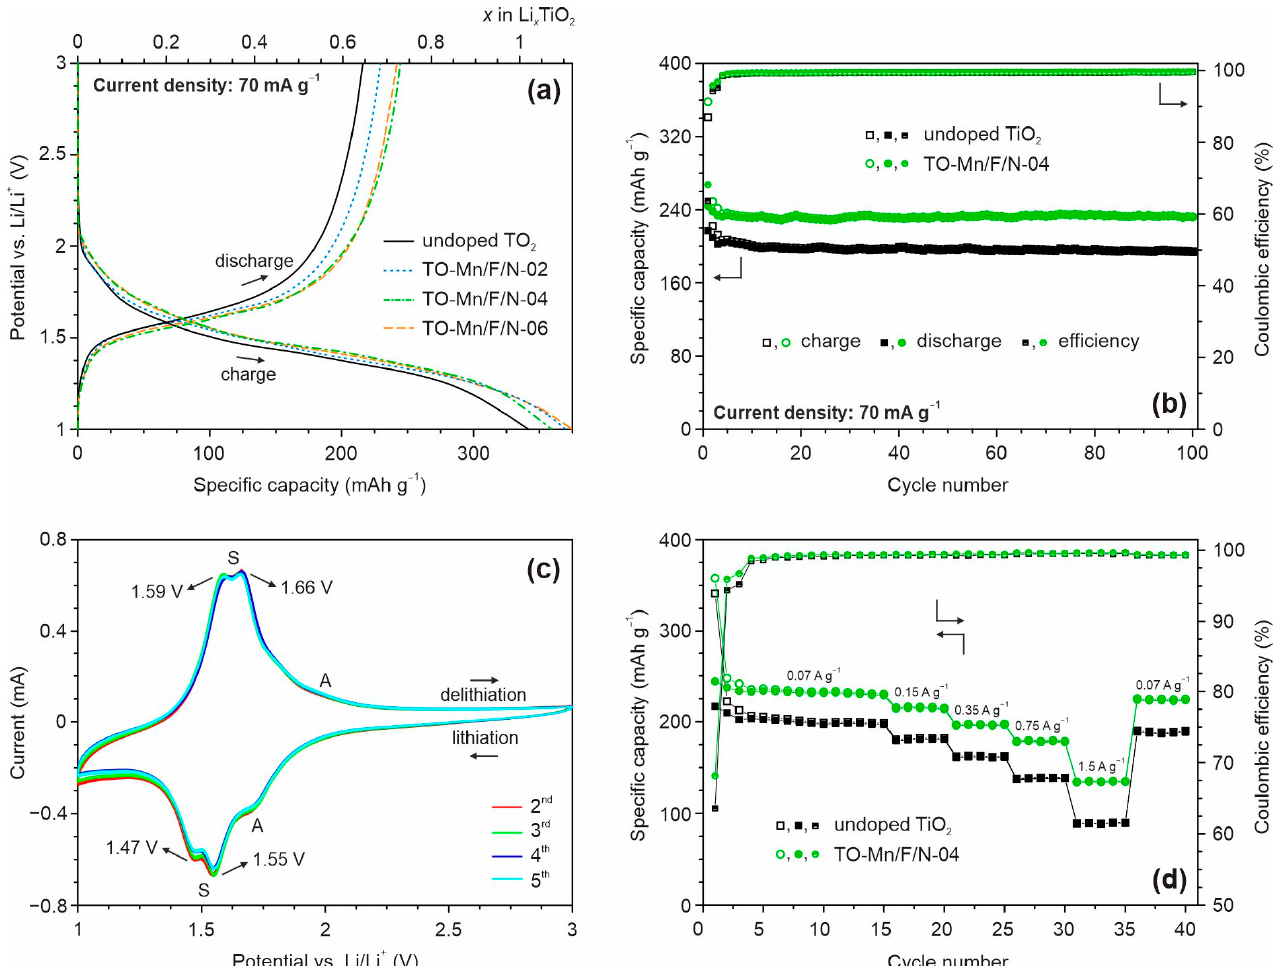
Figure 8. ( a ) Charge/discharge pro fi les of the fi rst cycle and ( b ) subsequent cycling at 70 mA g − 1 for undoped TiO 2 and TO-Mn/F/N-04 material, ( c ) CV curves for TO-Mn/F/N-02 electrode at a scan rate of 0.1 mV s − 1 , ( d ) rate capability at di ff erent current densities of unmodi fi ed and (Mn, F, N) co-doped TiO 2 (TO-Mn/F/N-04 sample) in the half-cell con fi